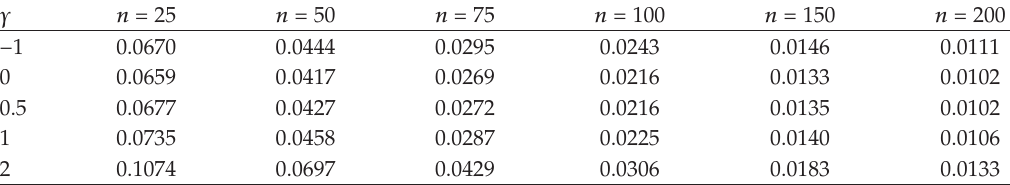
Table 4: MSE of the estimates for the exponential distribution, B (cid:6) 1000.